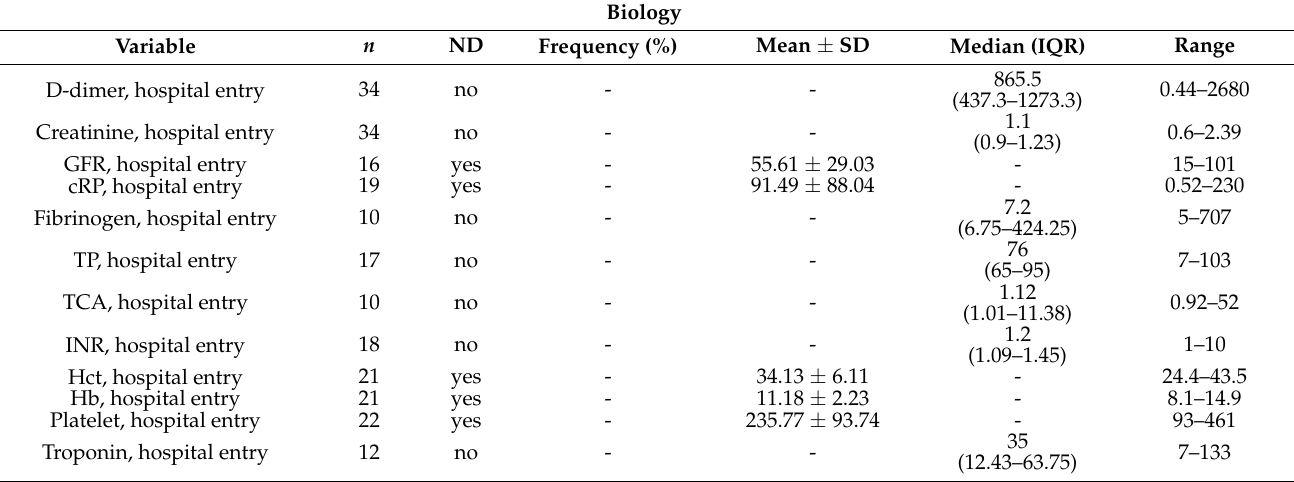
Table 4. Biologic parameters and descriptive